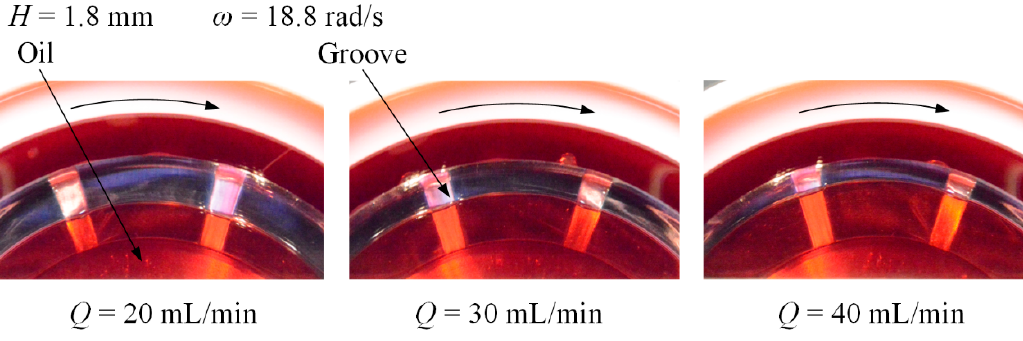
Figure 9. Comparison of the air–oil interface radial position with different inlet oil flow rates.